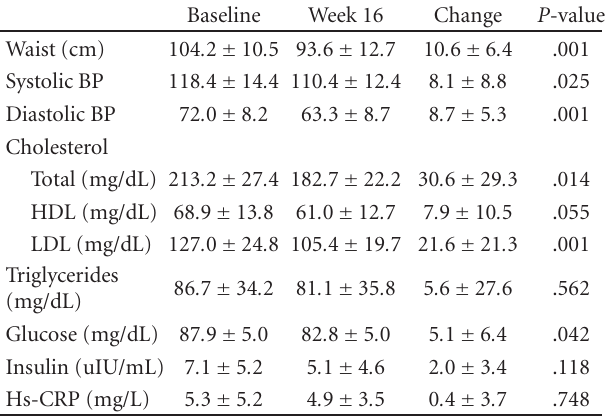
Table 1: Mean ( ± SD) changes in cardiometabolic risk factors ( N =